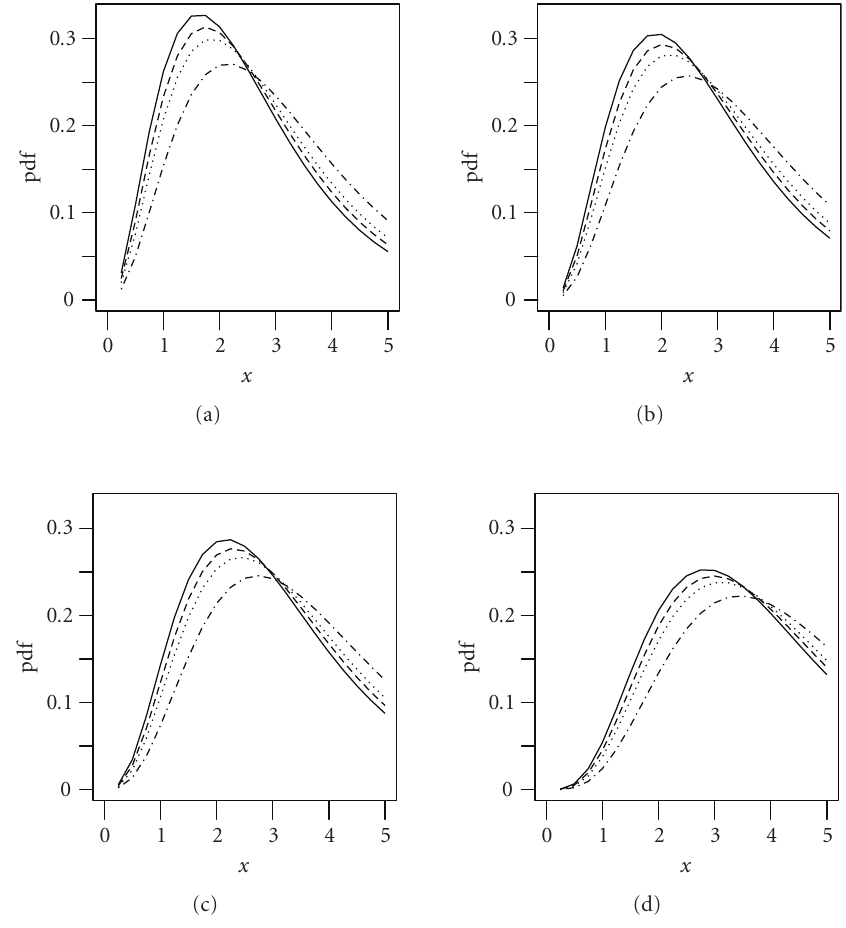
Figure 2.1. Plots of the pdf (1.5) for b = 1, β = 1 / 2, and (a) m = 1 . 1; (b) m = 1 . 3; (c) m = 1 . 5; and, (d) m = 2. The four curves in each plot from the left to the right correspond to n = 1 . 1,1 . 3,1 . 5,2.